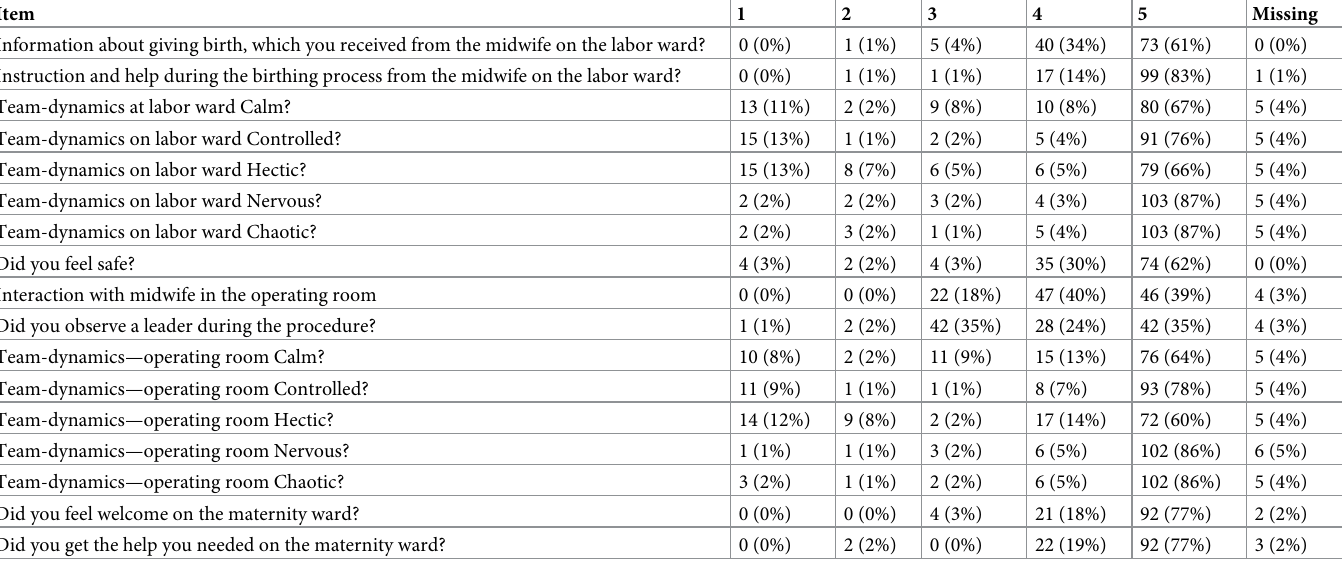
Table 3. Distribution of item responses from 119 mothers. Legend: 1: Low perception of care, 5: High perception of care. Item